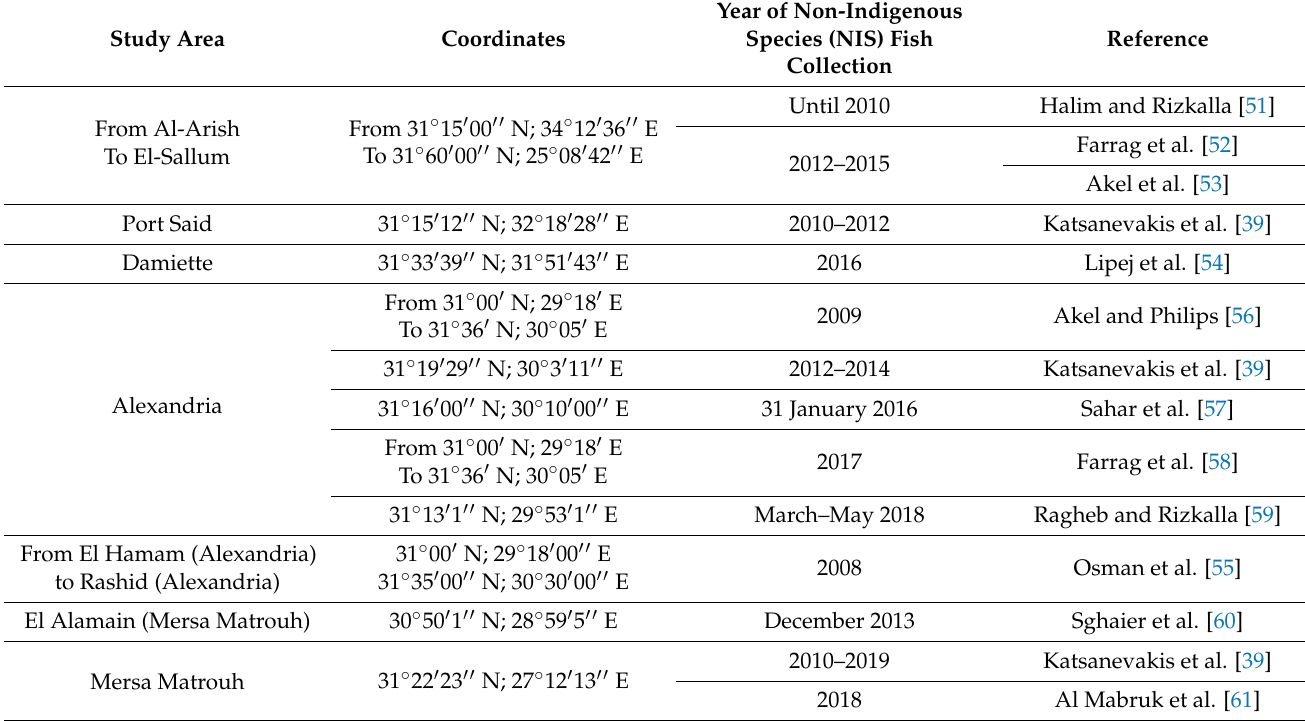
Table 1. Overview of study area and related coordinates; year of collection from 1991 to 2020; references and progressive reference number of the Egyptian Mediterranean coast studies where non-indigenous species were evaluated. Study Area Coordinates